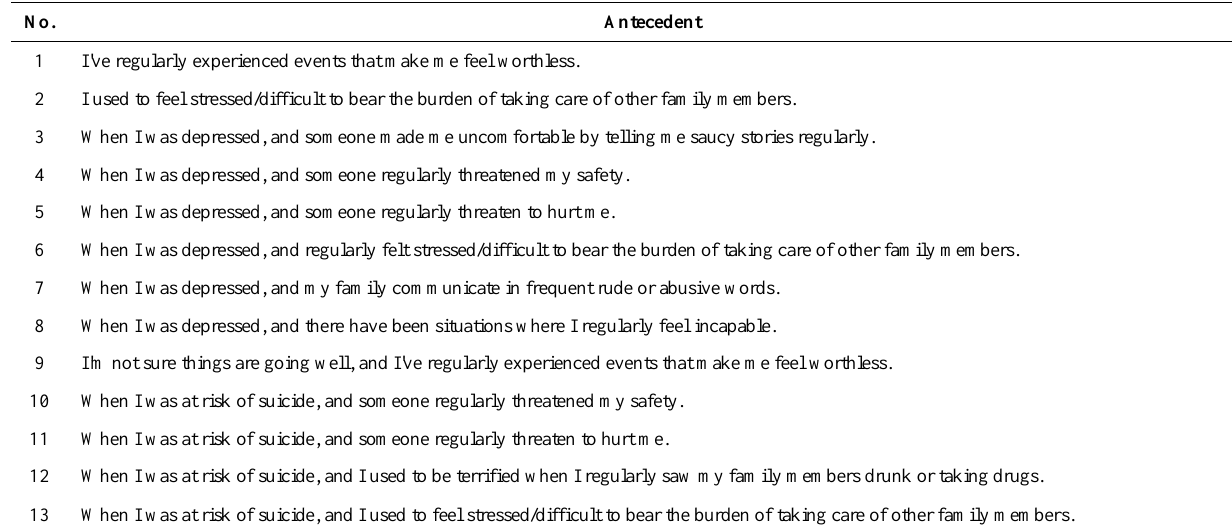
Table 1. Associated patterns resulting in high life